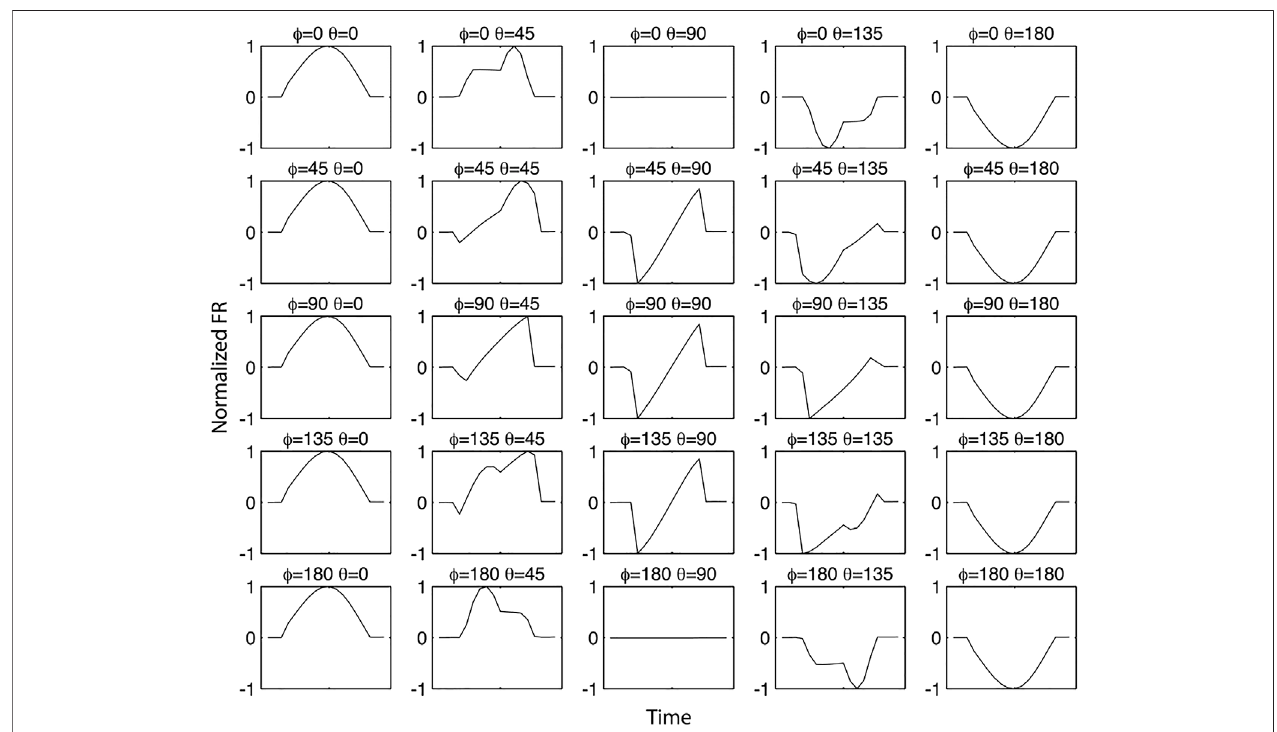
FIGURE 3 | Range of possible normalized FR pro fi les for a magnetic fl ux rope con fi guration with right-handed helicity. ϕ and θ are spherical angles that give the orientation of the axial magnetic fi eld vector. ϕ is the clock angle, which increases from 0 ° along the y -axis to 90 ° along the z -axis. θ is the cone angle, which is the offset anglefromthey-zplane.ThisappearsasFigure6inJensenetal.(2010),©TheAuthorsundertheCreativeCommonslicense(https://creativecommons.org/licenses/by/ 2.0/), reproduced with